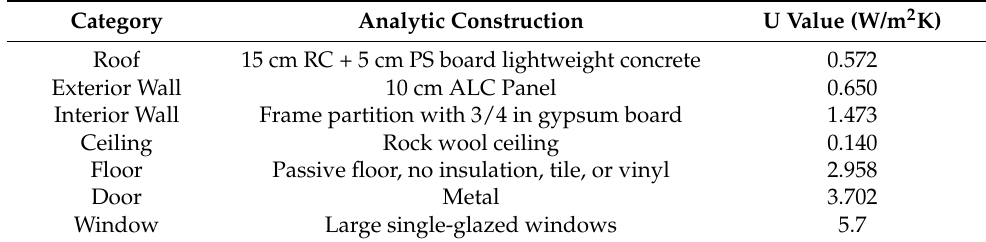
Table 4. Building material properties.